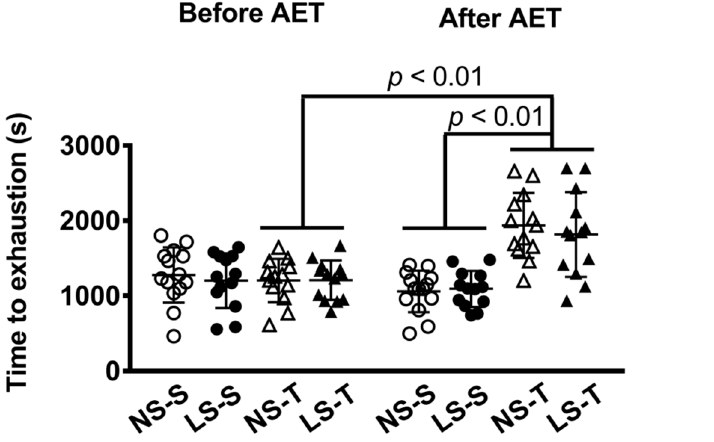
Figure 2. Time to exhaustion in treadmill exercise test before and after AET. Data presented as mean ± SD. Results compared by 3-way ANOVA (random factor: animal; fixed factor: time, diet and exercise) with Tukey’s post hoc test. p exercise*time < 0.01; p exercise*diet*time = 0.32. NS = normal-sodium diet; LS = low-sodium diet; S = sedentary; T = trained. NS-S n = 14; NS-T n = 13; LS-S n = 13; LS-T n = 13. Table 1. Characterization of groups before intervention.